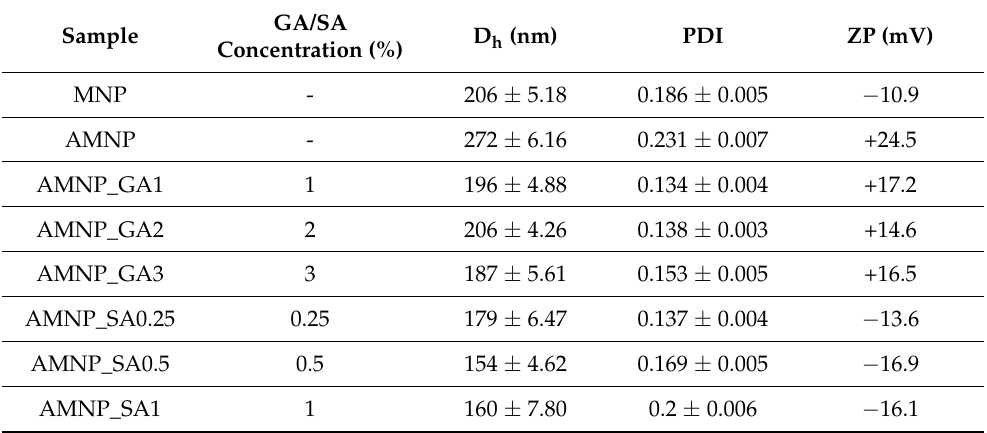
Table 1. Characteristics obtained in the DLS determinations for pristine MNPs, AMNPs and those functionalized with GA/SA.